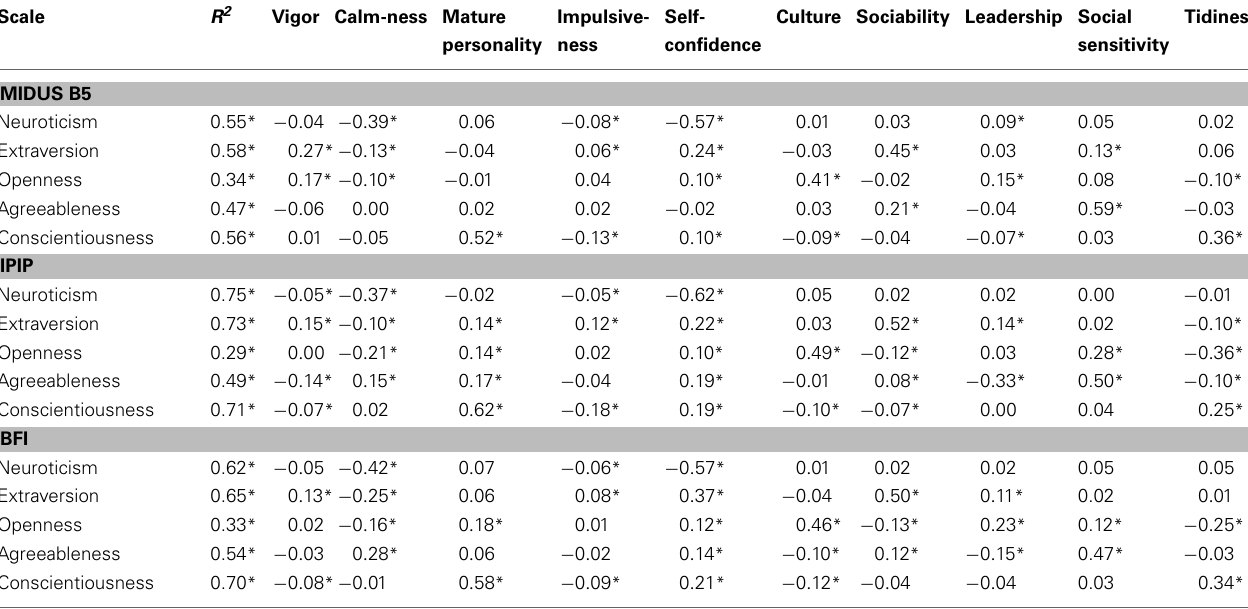
Table 5 | Multivariate regressions of each Big Five personality scale on the 10 PTPI Scales (included in the same model). Scale R 2